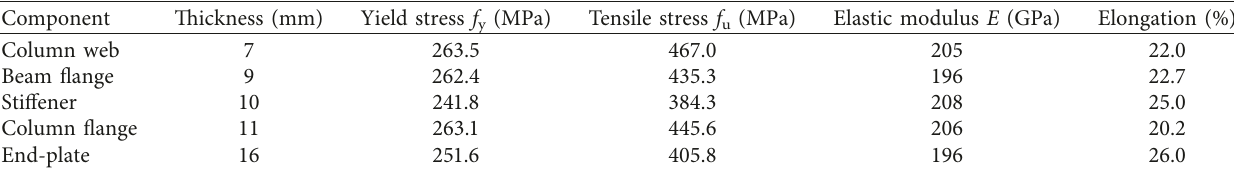
Table 2: Material properties of steel.